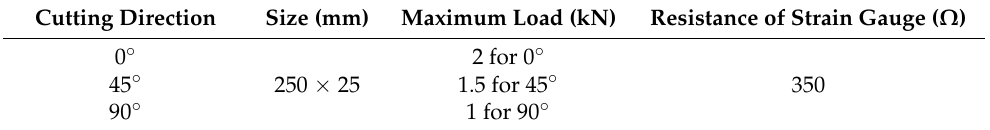
Table 1. Parameters of CFRP samples, load, and sensor for tensile loading.